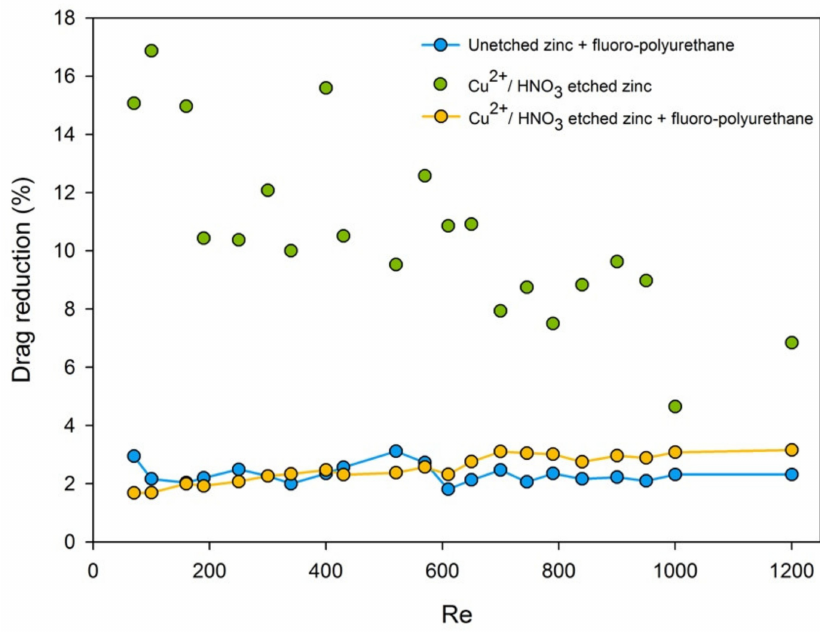
Figure 9. Drag-reduction rate–Reynolds number diagram of the superhydrophilic / hydrophobic surface compared with an unetched zinc substrate at h = 192.53 µ